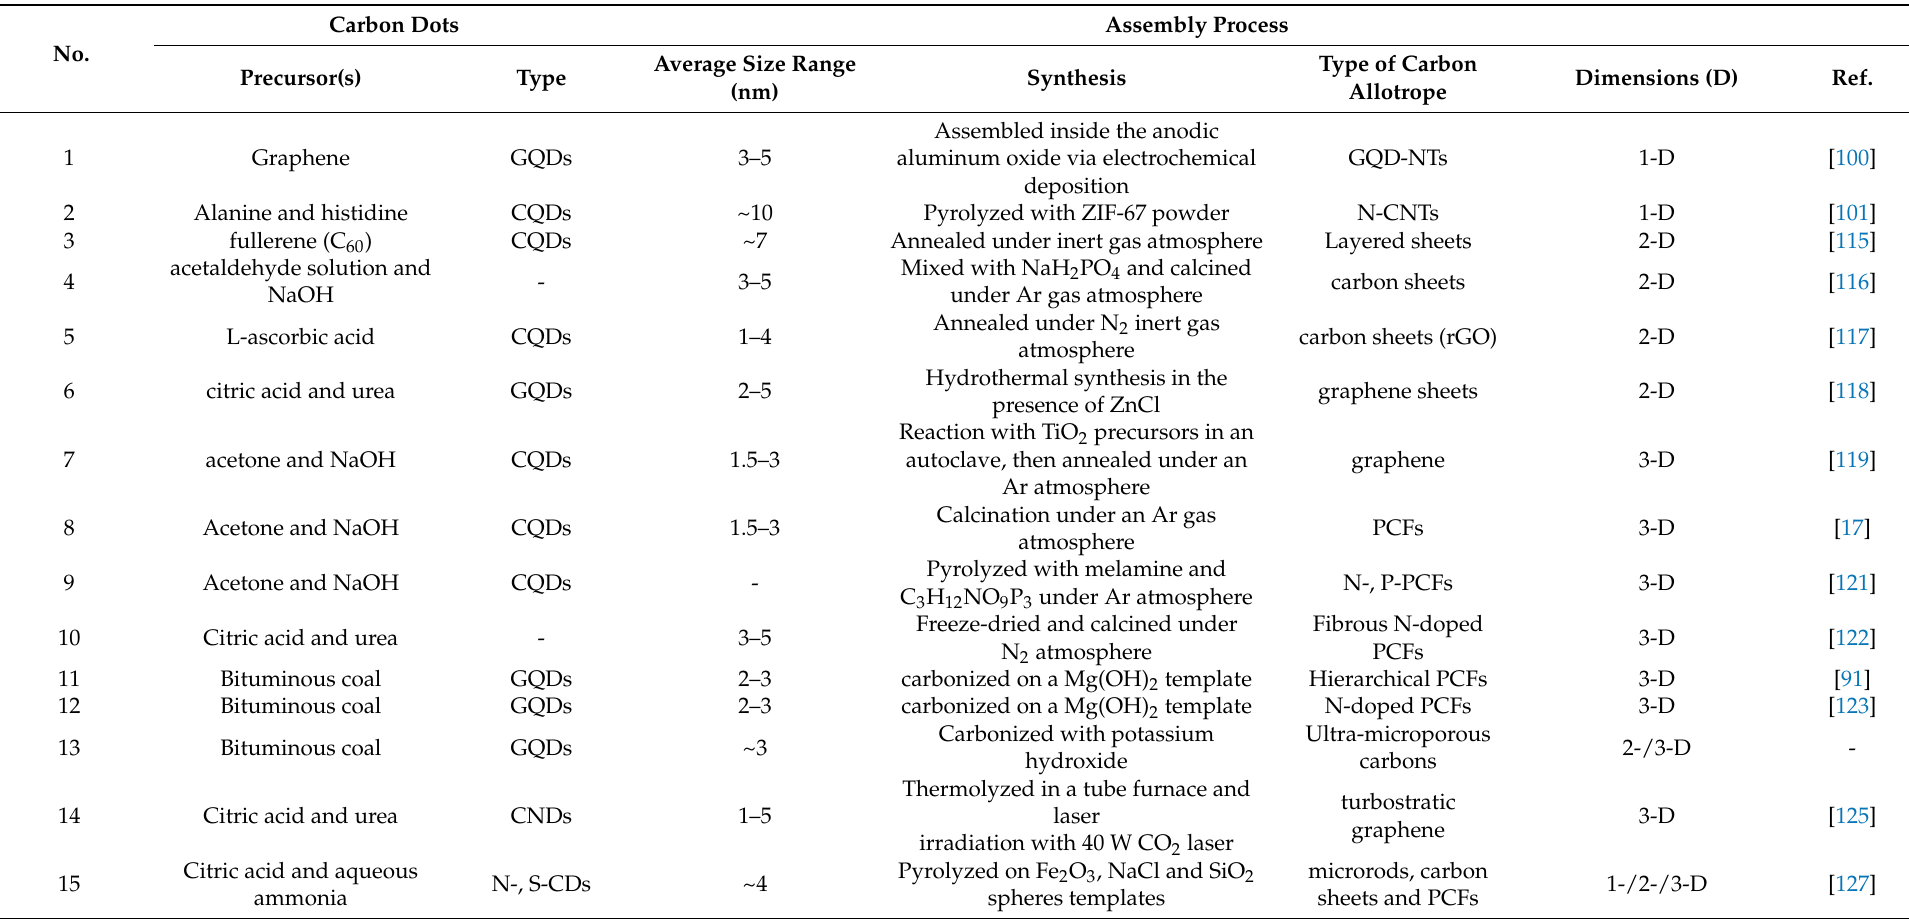
Table 1. A summary of the methodologies followed for the transformation of 0-D CDs into 1-, 2- and 3-D carbon